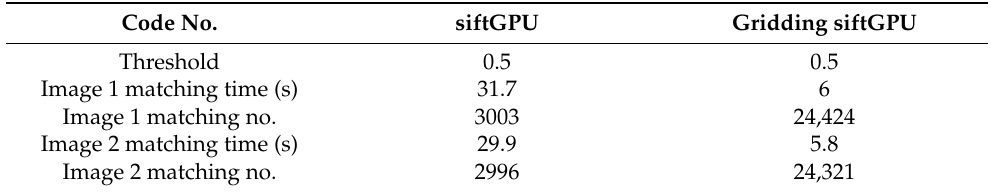
Table 2. Matching time and feature points